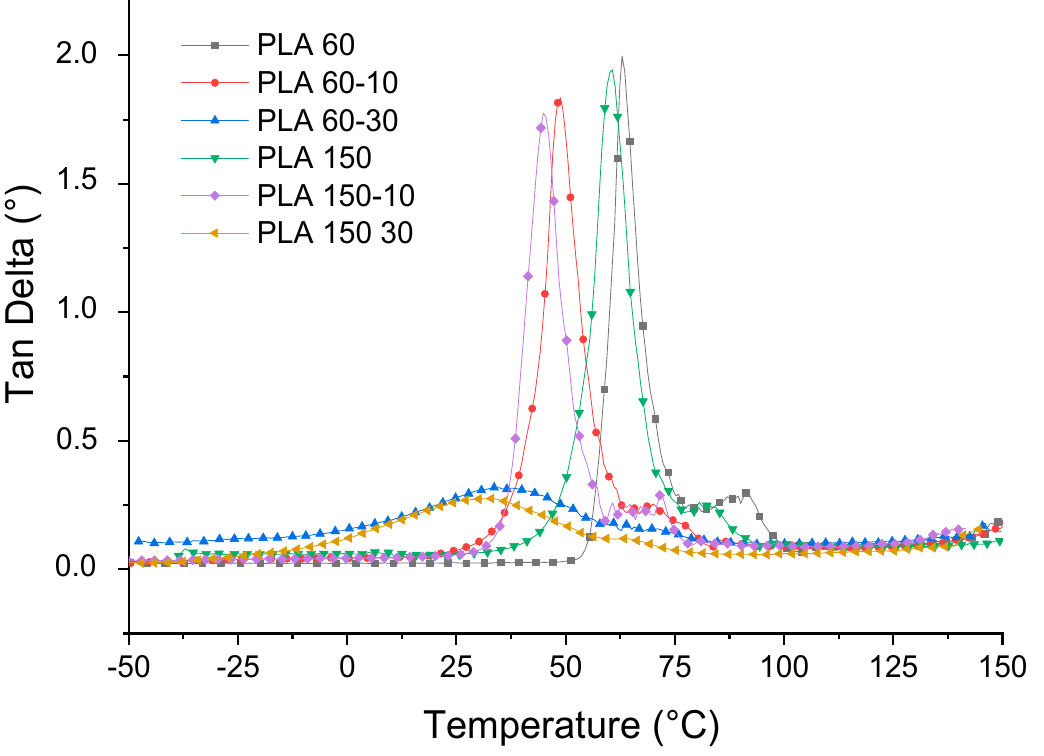
Figure 14. Tan delta for PLA and PLA/ATBC.